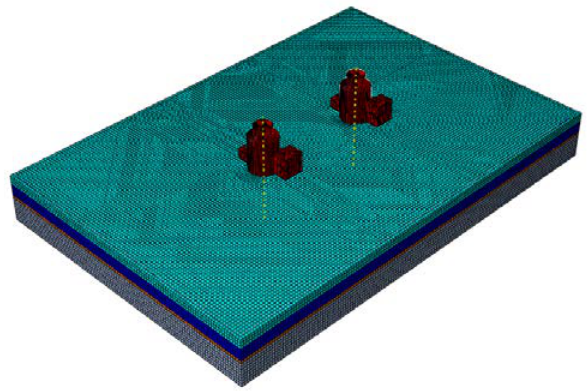
Figure 1. Finite element of the soil–structure interaction.